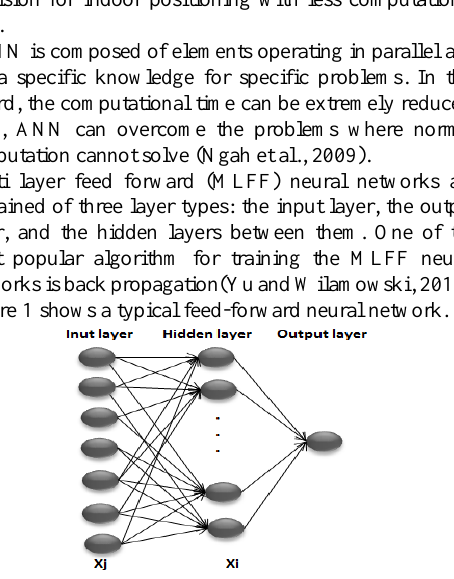
Figure 1. Typical feed-forward neural network composed of three